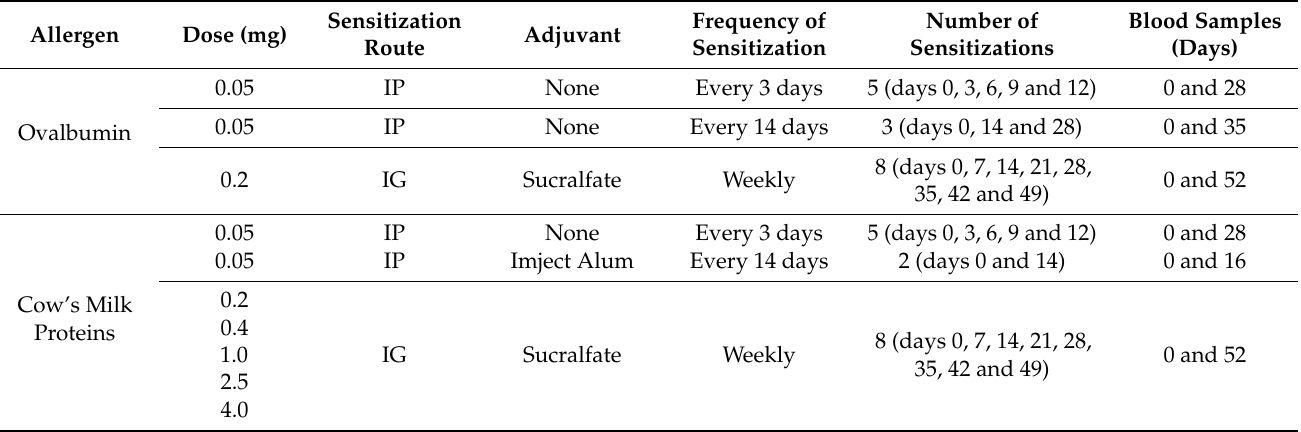
Table 1. Intragastric and IP protocols of